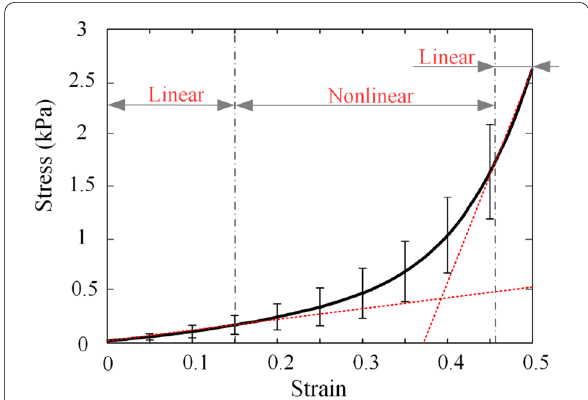
Figure 5 Stress-strain curve in compression experiment